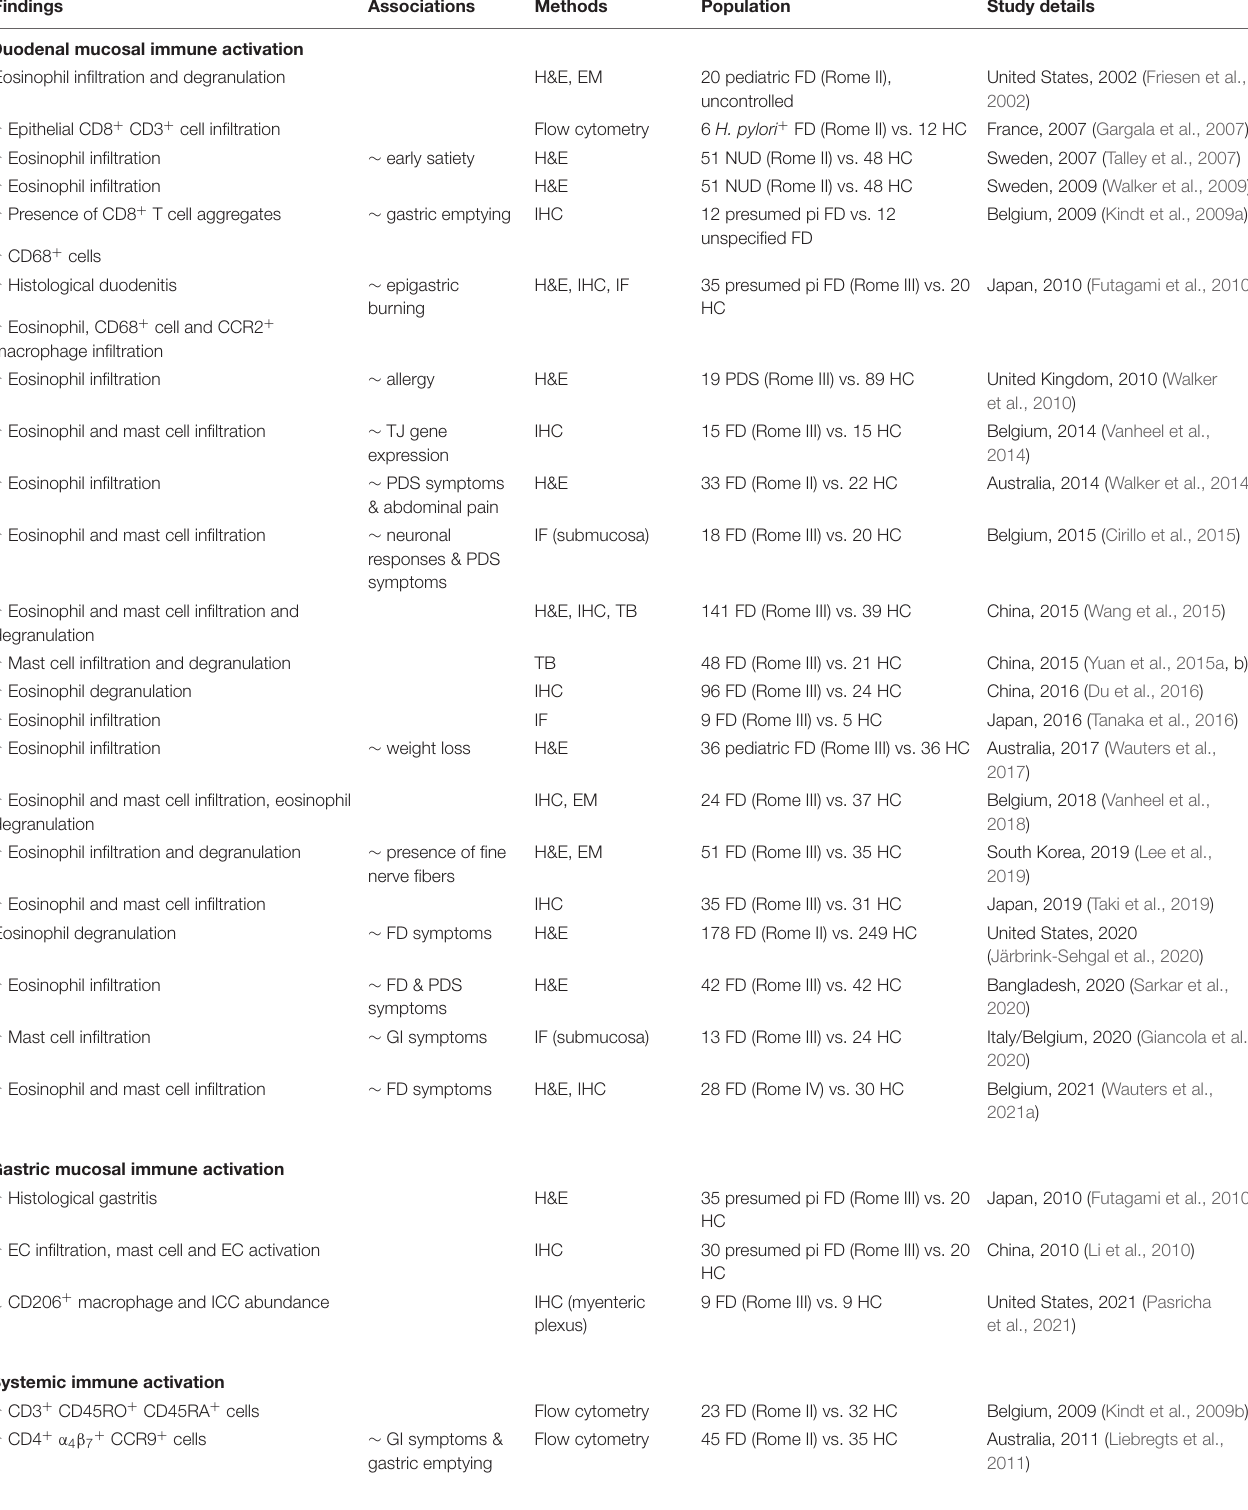
TABLE 1 | Evidence for immune activation in functional dyspepsia at the cellular